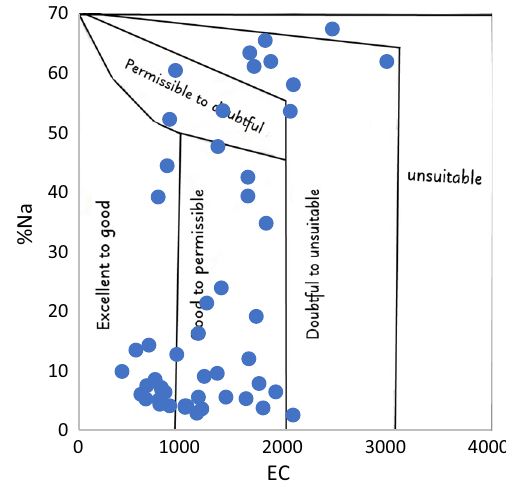
Fig. 9 Wilcox diagram of EC versus Na%